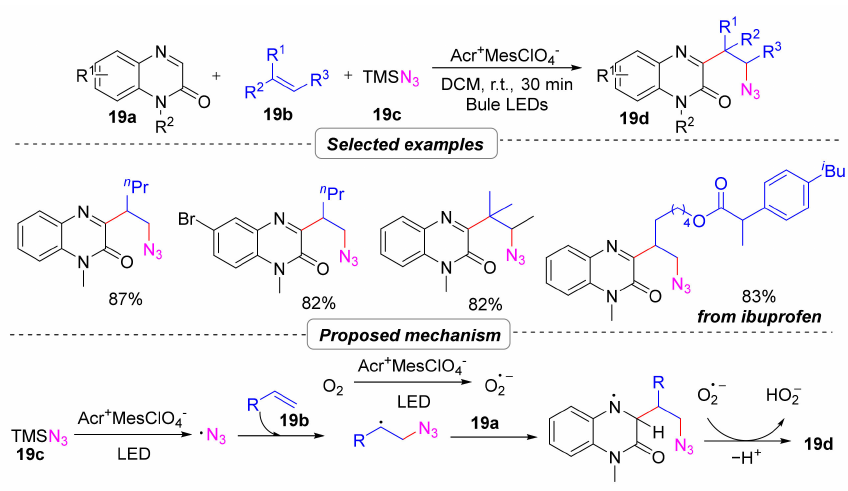
Scheme 20. Photoinitiated multicomponent cascade reaction of